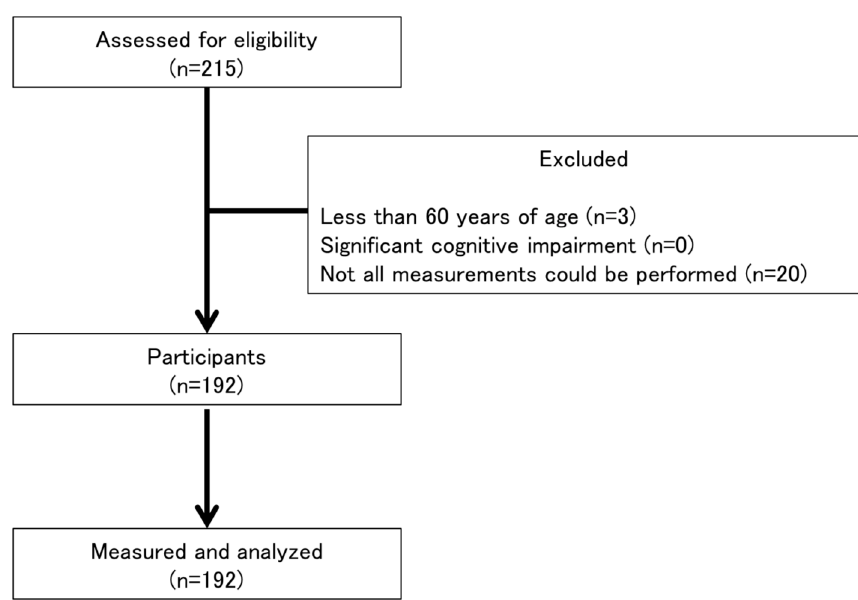
Figure 1. Flowchart of participation in the present study.